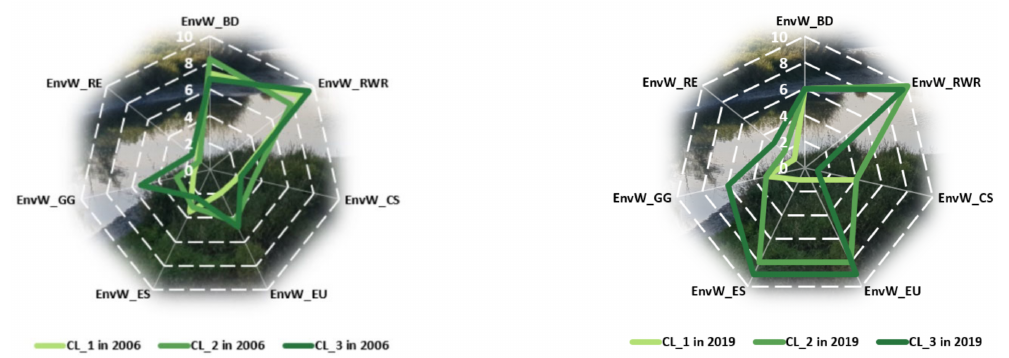
Figure 7. Comparison among clusters regarding environmental wellbeing components in 2006 vs. 2019. Source: SSI database, computed in Microsoft Excel